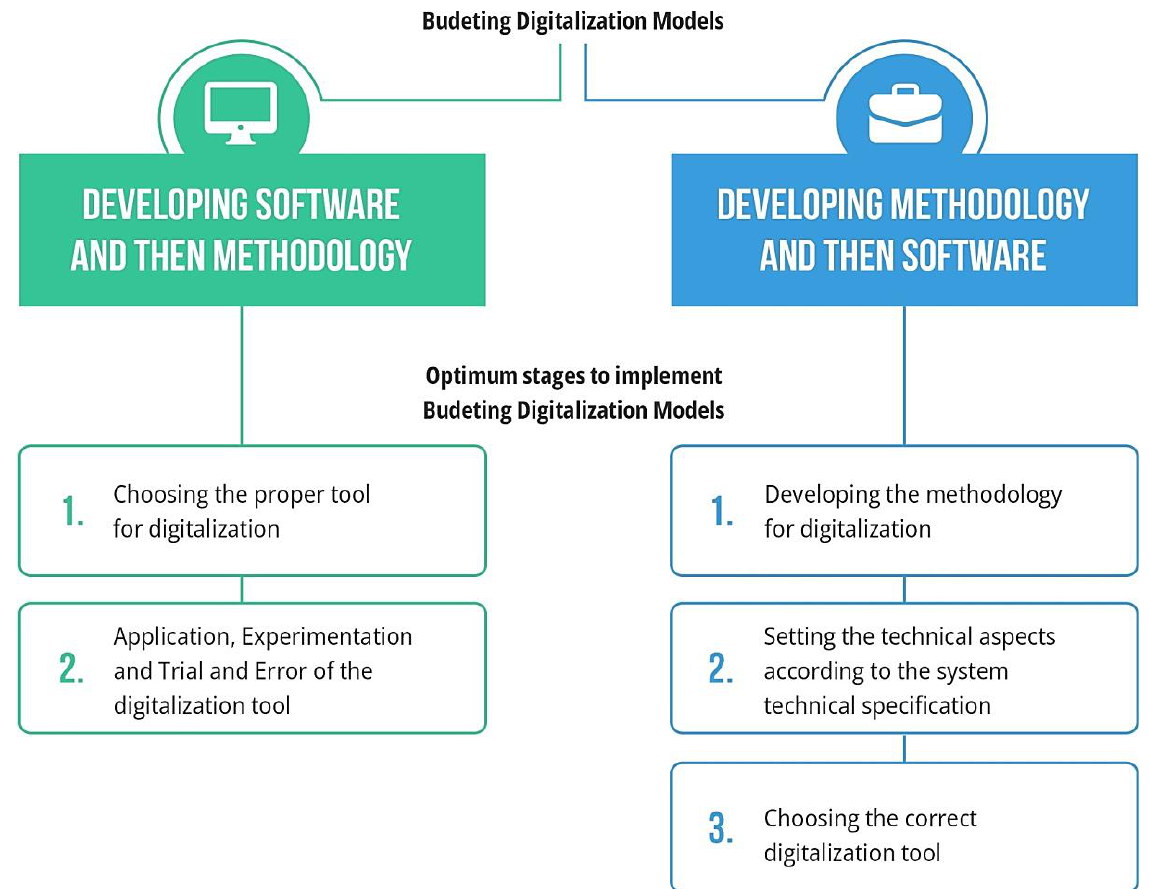
Figure 1. Models of